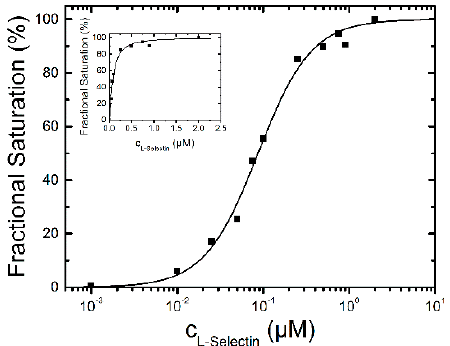
Figure 3. L-selectin-binding curve to 0.1 µM dPGS-ICC in DPBS at 20 °C. The concentrations are plotted on a logarithmic scale. The inset shows the data on a linear scale. The half maximum binding concentration was determined to be 87 ± 4 nM with a Hill-coefficient of n = 1.4.